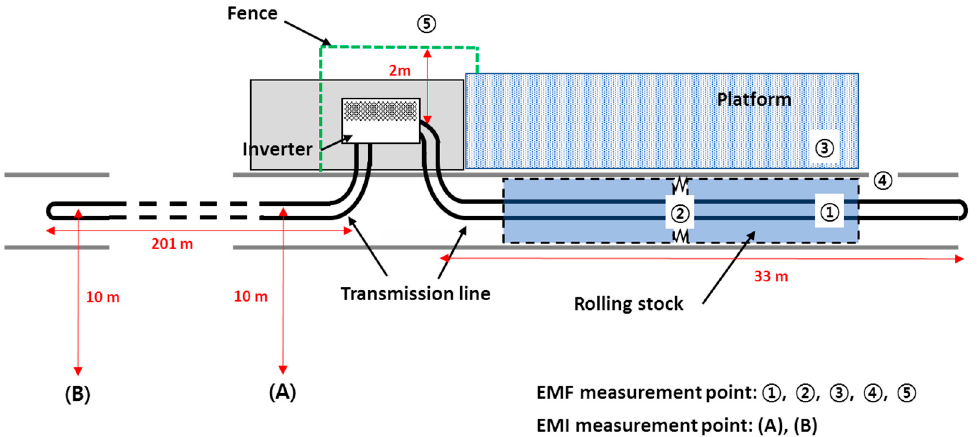
Figure 7. Measurement points for EMF and EMI.